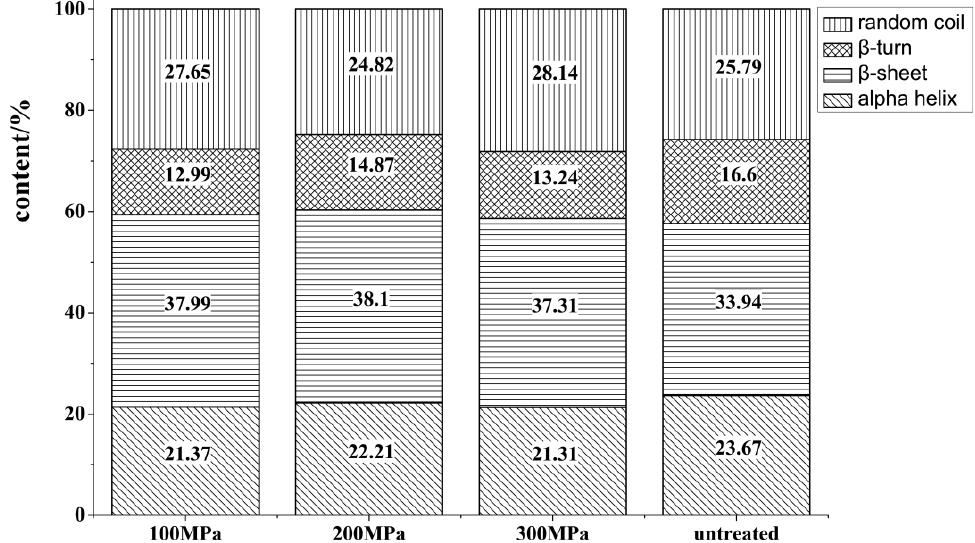
Figure 7. Changes in the secondary structure mass fraction of organic matter in scallop shells under ultra-high pressure.